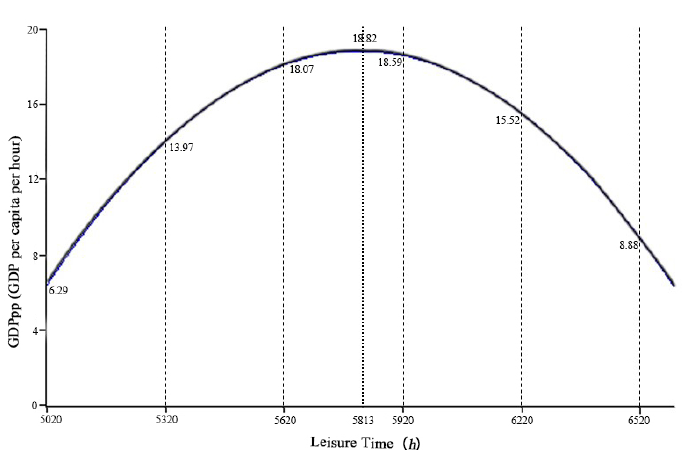
Figure 1: Curvilinear Relationship between l and GDPpp